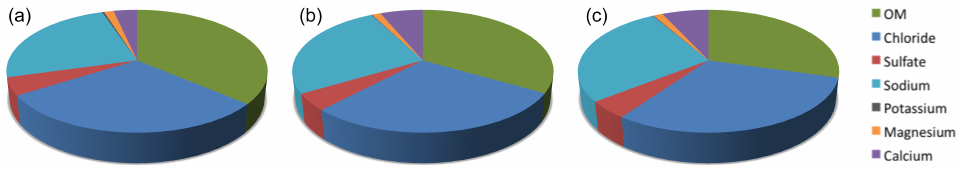
Figure 6. Average chemical composition of the PM 1 PMA generated from seawater of (a) mesocosm A (control), (b) mesocosm B (enriched) and (c) mesocosm C